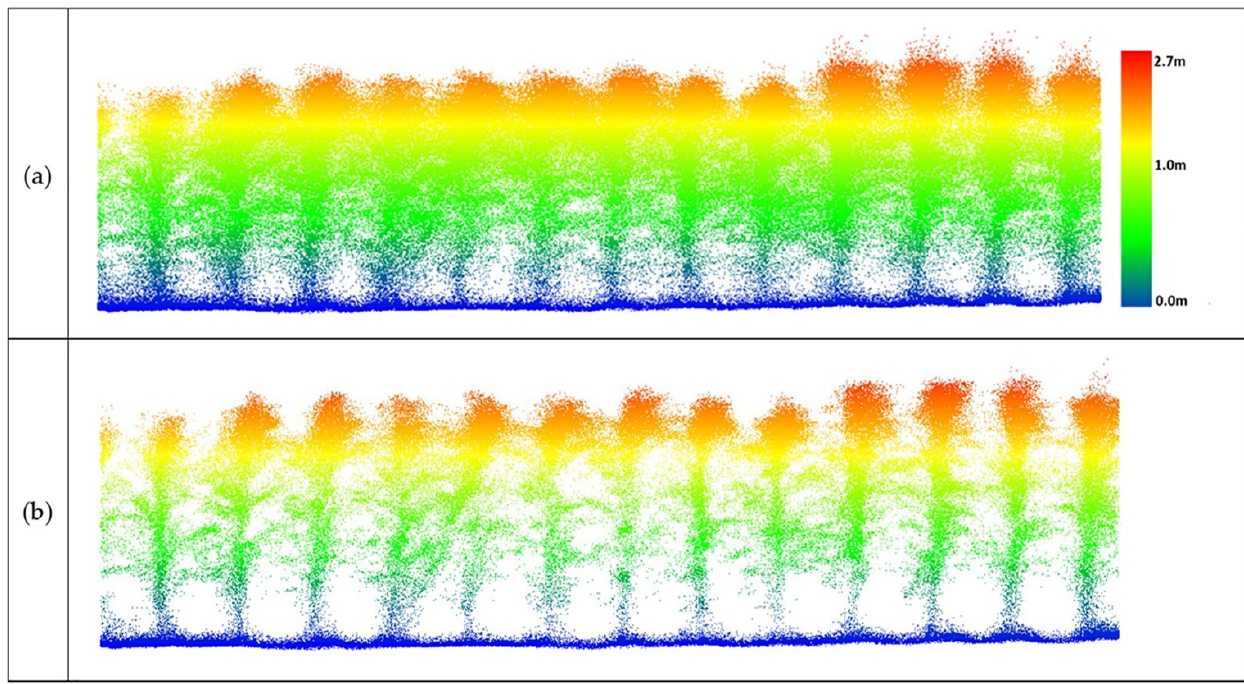
Figure 19. Data from UAV-2 at the altitude of 20 m over maize (DAS: 60). ( a ) Original point cloud perpendicular to the direction of the rows; ( b ) results of outlier removal using PointCleanNet.